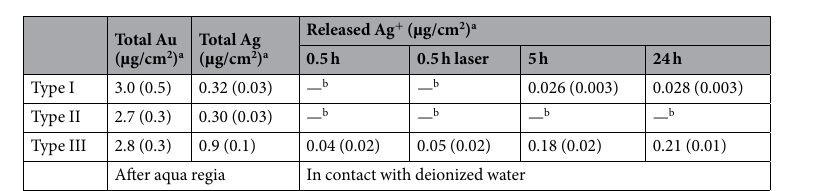
Table 1. Total content and released fraction of metals on Type I, II, and III s urfaces. (see also SI10). a Average values from at least three samples with standard deviations reported between brackets; b Under detection